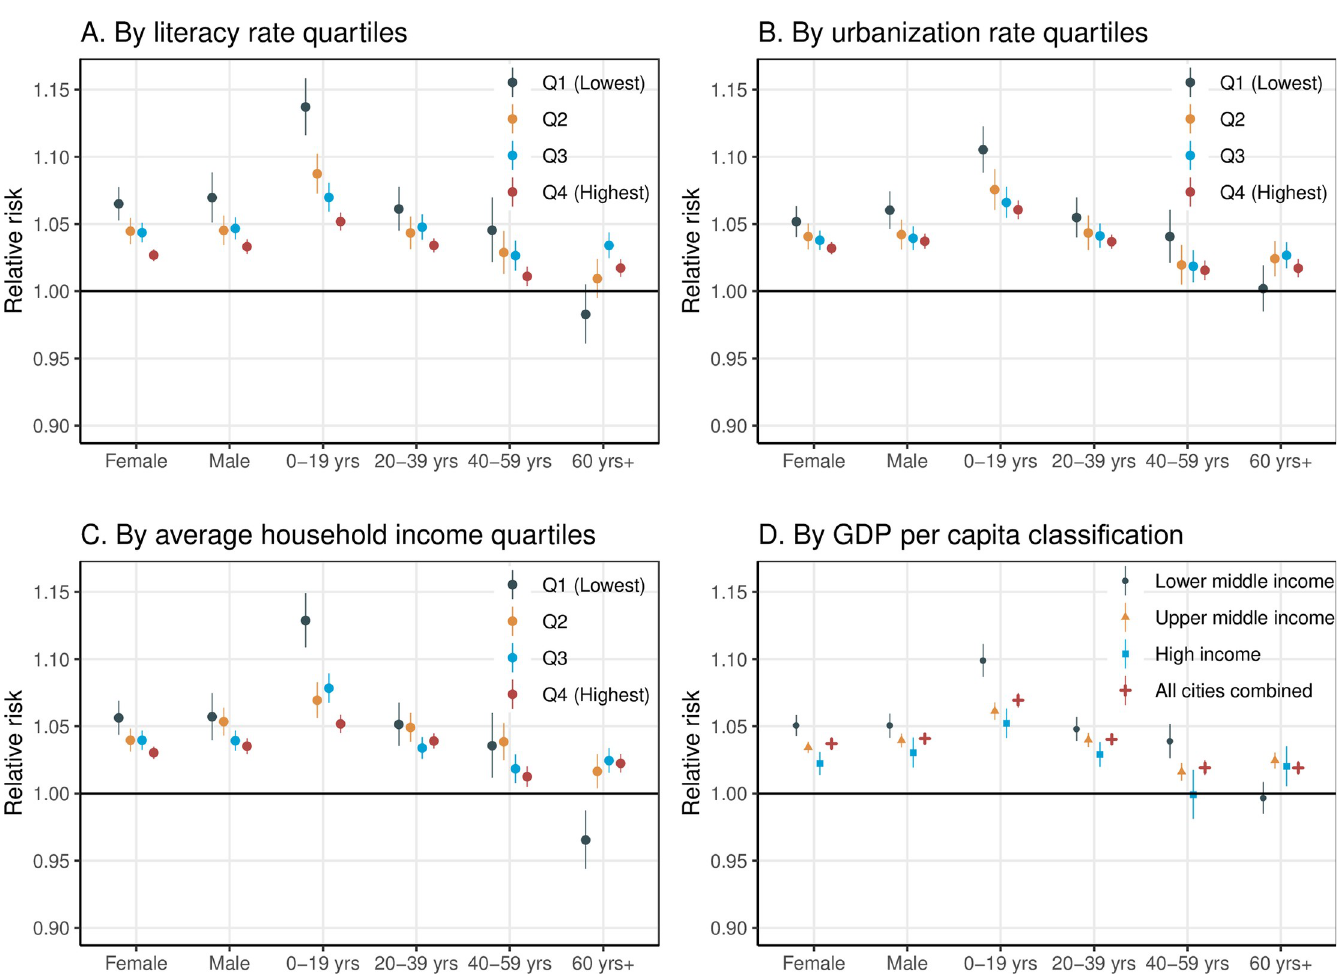
Fig 3. The association between heat exposure (for every 5˚C increase in daily mean temperature) and hospitalization during lag 0–7 days, stratified by socioeconomic level, sex, and age group. Literacy rate (A), urbanization rate (B), household income (C), and GDP per capita (D). Q1–Q4 represent 4 quartiles from the lowest to the highest. GDP per capita classifications were based on the World Bank’s 2015 standard. CI, confidence interval; GDP, gross domestic product. (meta-regression P value = 0.024), urbanization rate (meta-regression P value = 0.033), average family income (meta-regression P value = 0.015), and log(GDP per capita) (meta-regression P value = 0.004) (Fig 5). The modifying effects of the 4 socioeconomic indicators on city-specific